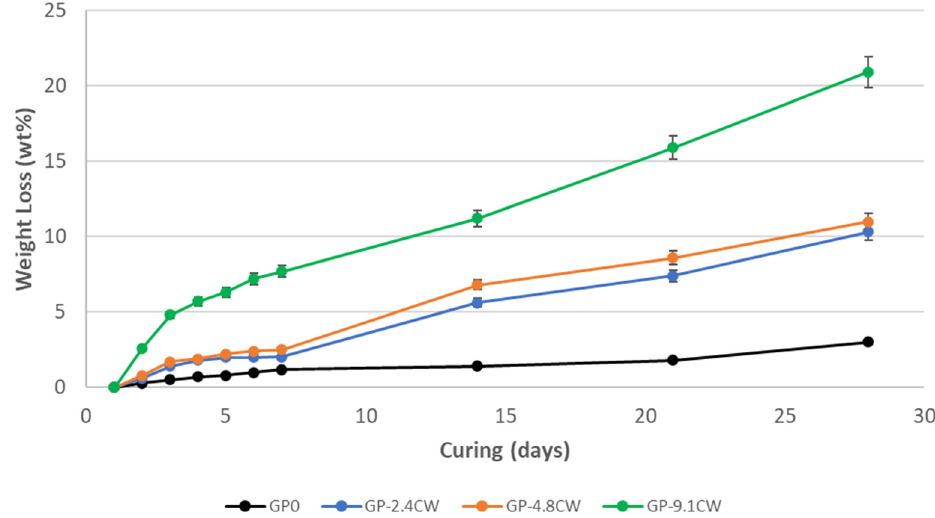
Figure 3. Weight loss of all geopolymers during the first 28 days of ageing. Table 2. Percentages of total water, water loss and retention in the different formulations after 28 days of ageing.